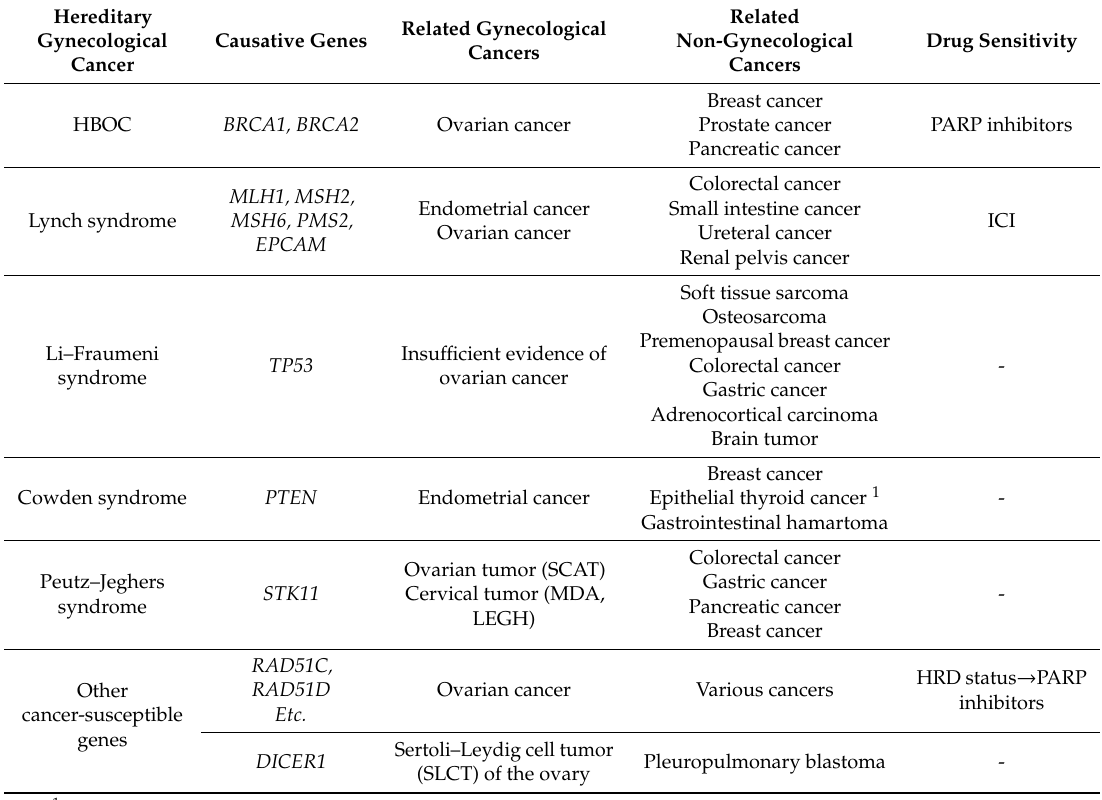
Table 1. Molecular feature and clinical management of hereditary gynecological